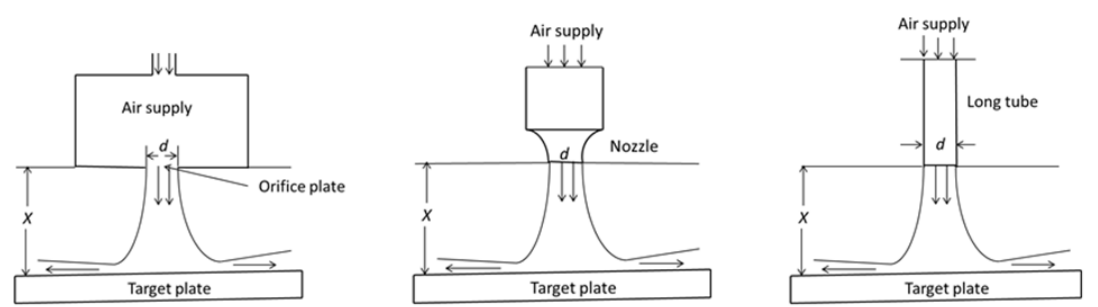
Figure 2. The different geometries (orifice plate, nozzle and long tube) used to produce an impinging jet.